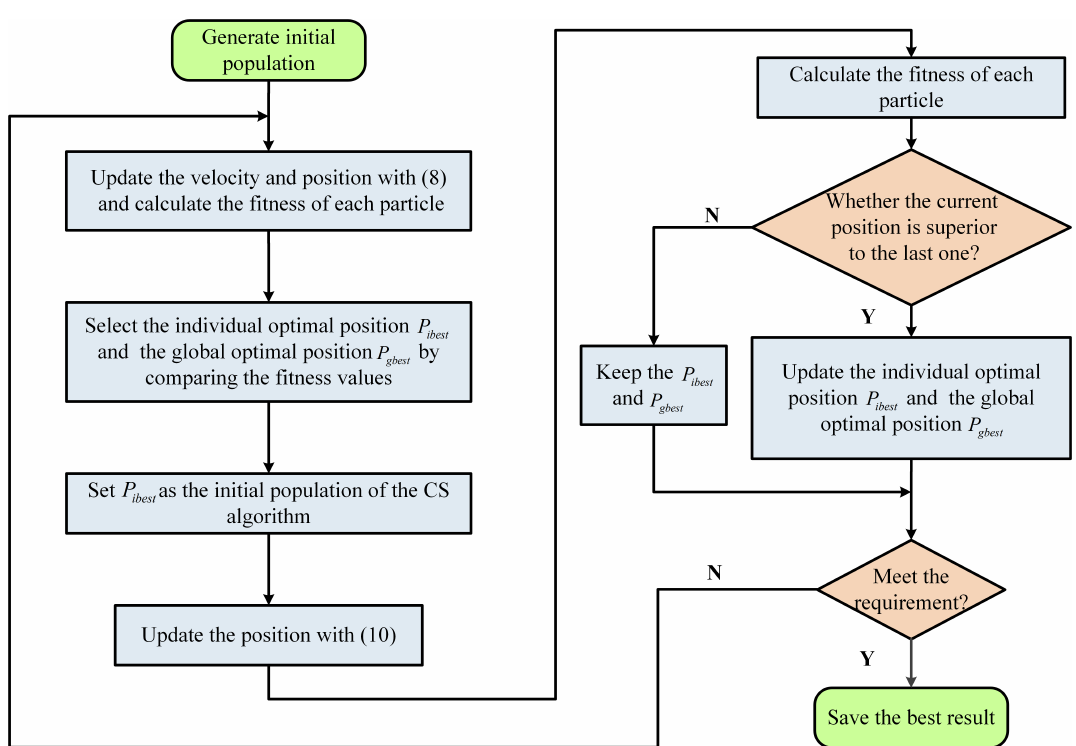
Figure 4. Flow chart of Particle Swarm Optimization and Cuckoo Search (PSO-CS) hybrid optimization algorithm.